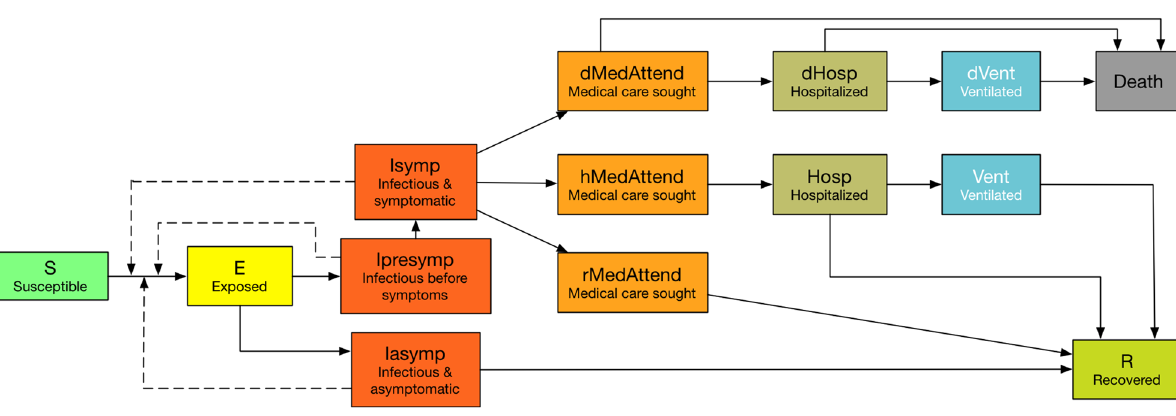
Figure 2. Disease states and transition paths in the COVID-19 disease